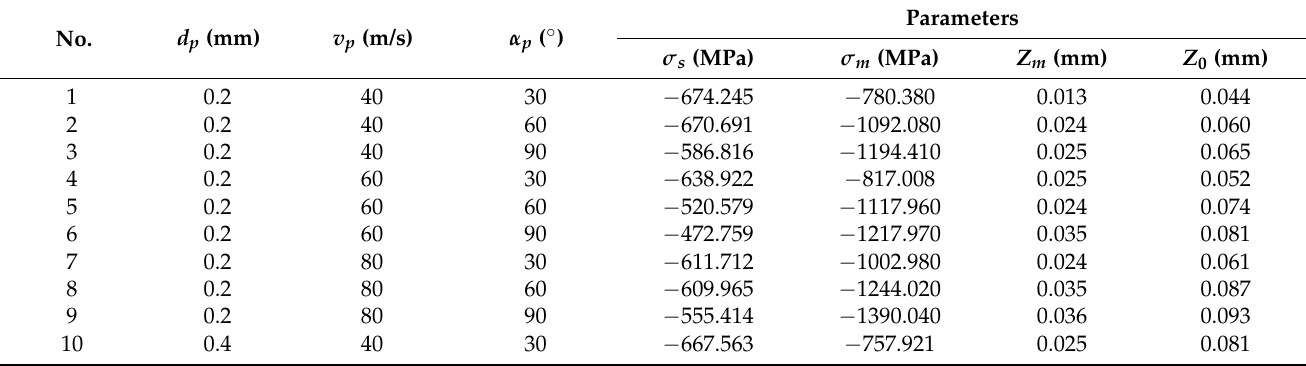
Table 3. Original simulation results of residual stress.